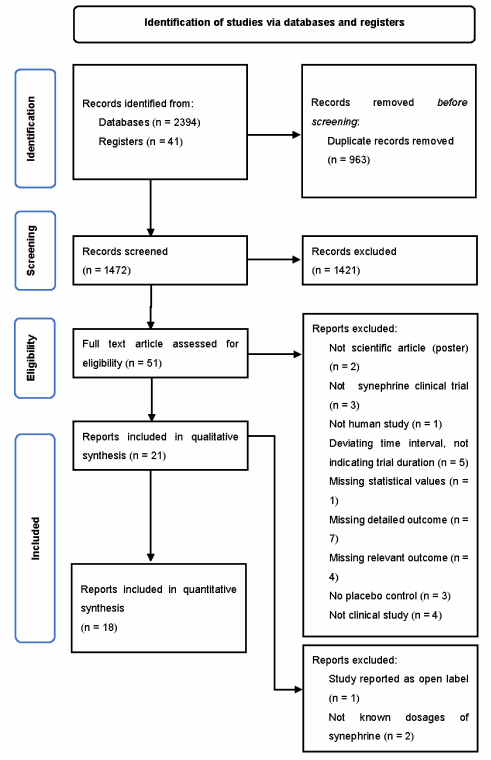
Figure 2. A flow diagram for identification of relevant